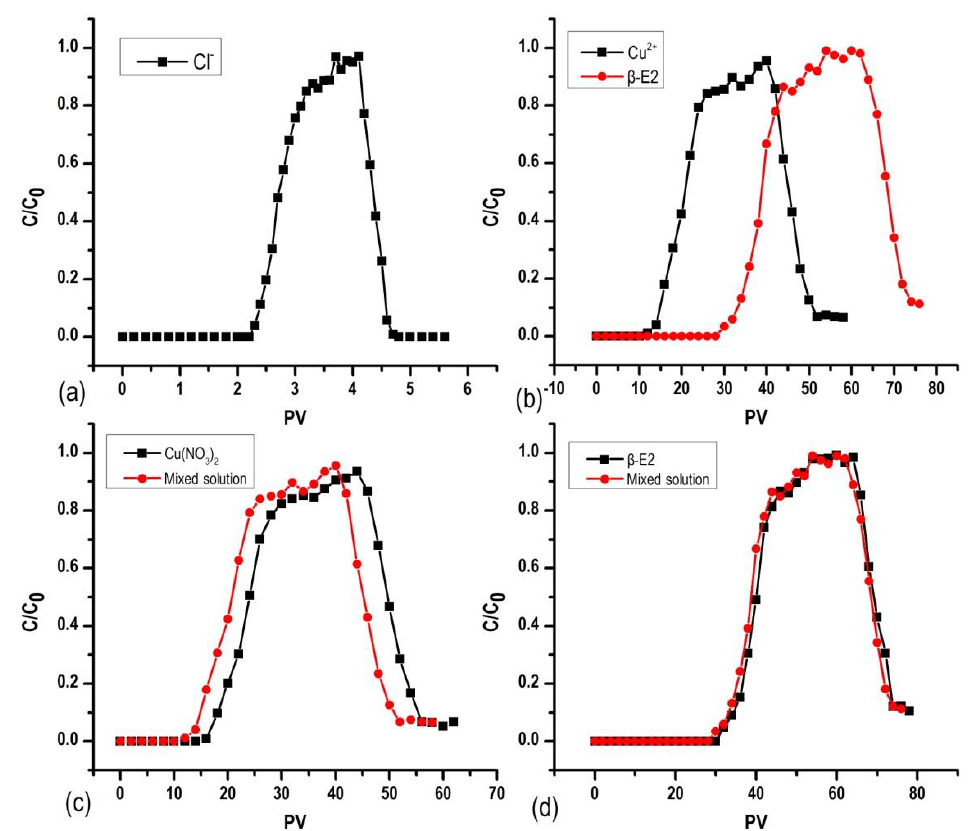
Figure 6. Breakthrough curves of ( a ) a tracer, ( b ) 17β-E2 and Cu 2+ in mixed solution, ( c ) Cu 2+ in Cu(NO 3 ) 2 and mixed solution, and ( d ) 17β-E2 in 17β-E2 and mixed solution.